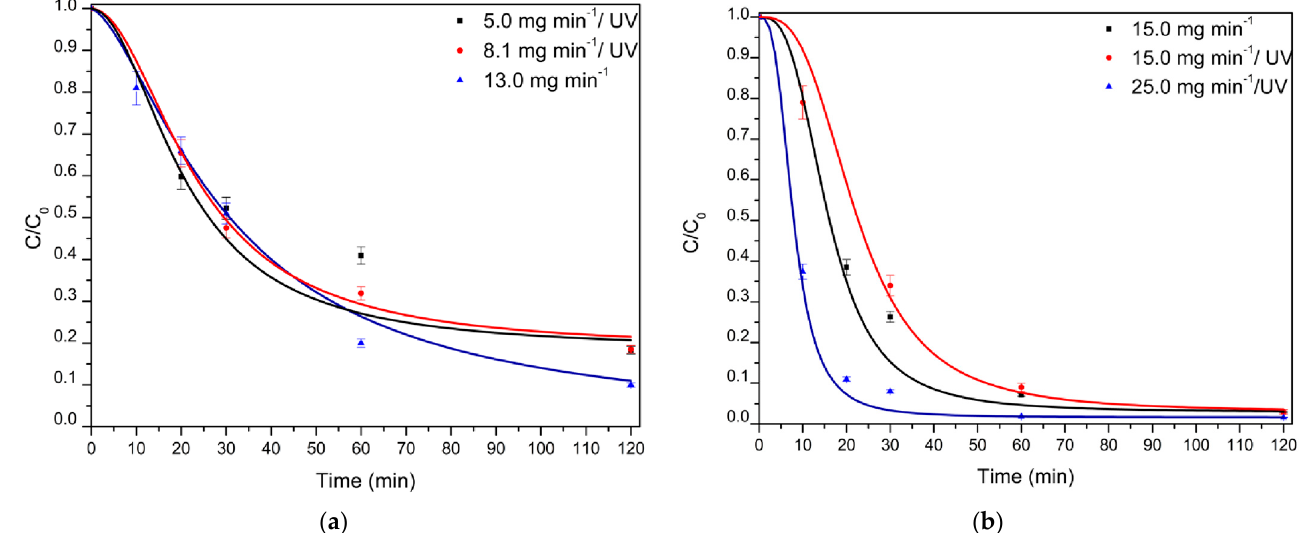
Figure 8. Normalized AMX concentration (C/C 0 ) abatement kinetics for photolytic (30-wa UV) and non-photolytic processes. pH 13.00 in all experiments. LP-Hg lamps (254 nm). ( a ) Ozone doses at 5.0, 8.13, and 13.0 mg min − 1 . ( b ) 15.0 and 25.0 mg min − 1 .